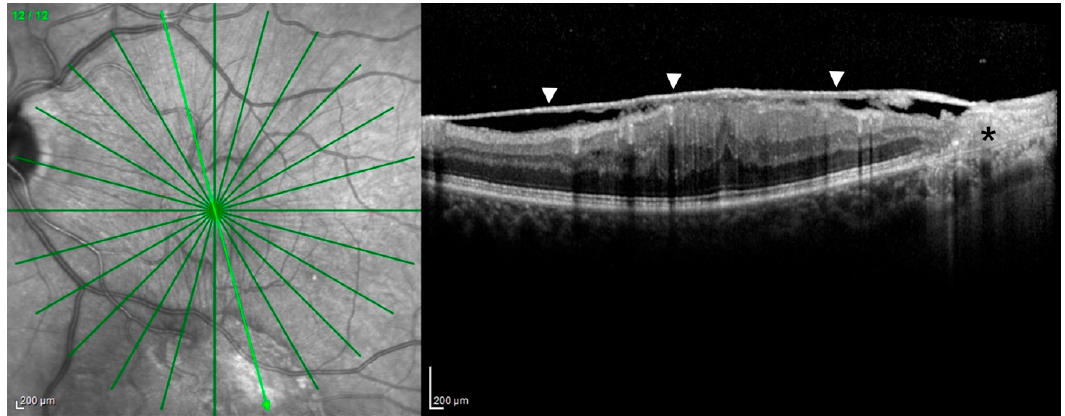
Figure 10. Toxoplasma gondii-related epiretinal membrane. On OCT, a hyperreflective membrane ( arrowheads ) can be seen adjacent to a toxoplasma scar ( asterisk ).